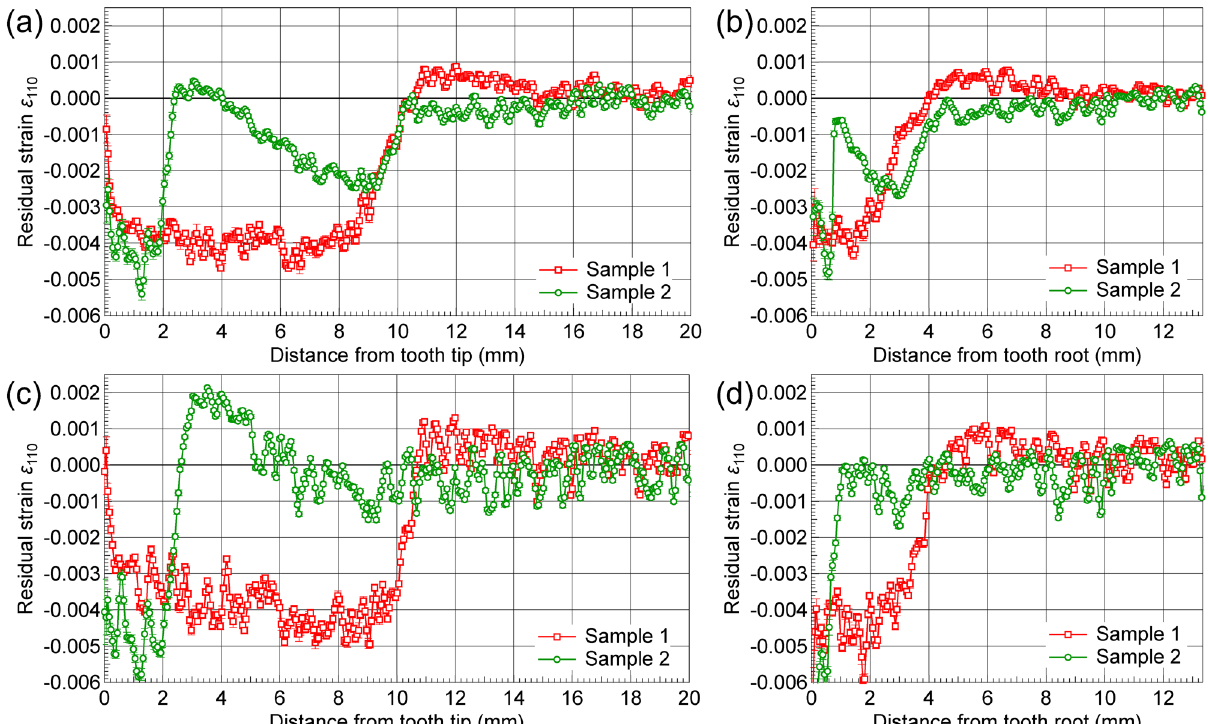
Figure 12. Residual strain of 110 lattice plane, ε 110 , determined via Bragg-edge imaging: from tooth tip ( a , c ) and tooth root ( b , d ) to core, as indicated by the arrows in Fig. 11c,d, where ( a , b ) are calculated from d 110 values in Fig. 9a,b, and the fitted Hv values in Fig. 6a,b., and ( c , d ) are calculated from d 110 values in Fig. 9a,b, and the w 110 values in Fig.